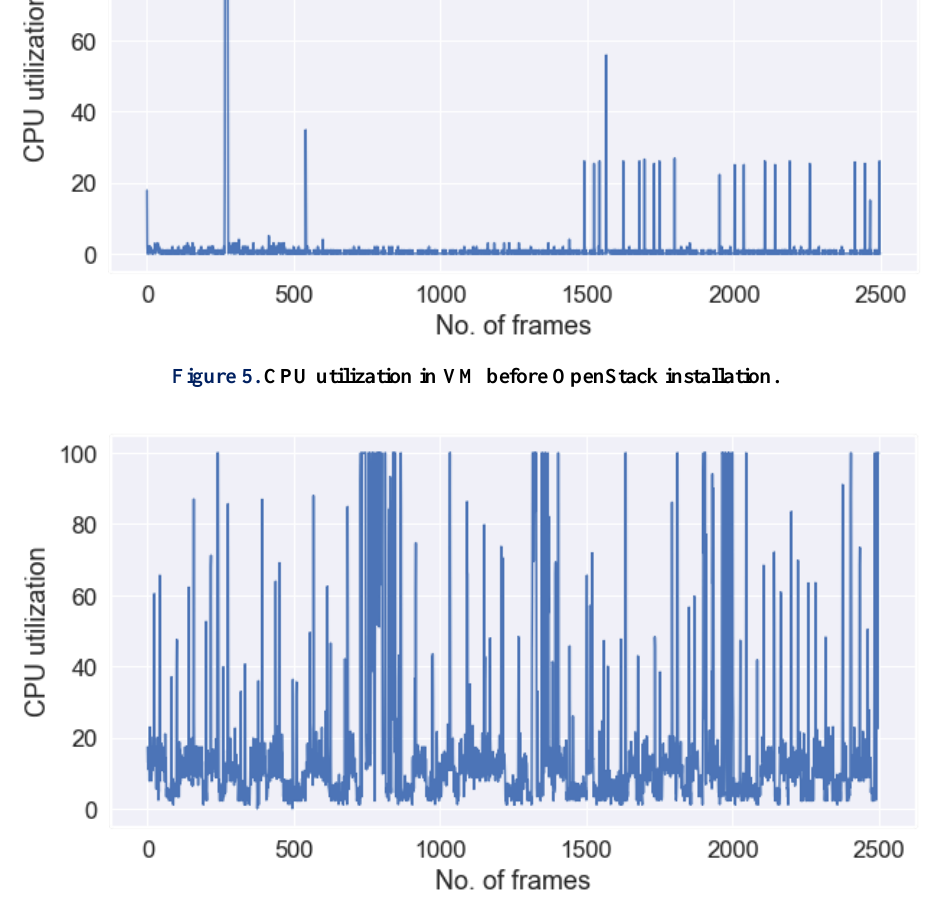
Figure 6. CPU utilization in VM after OpenStack installation.